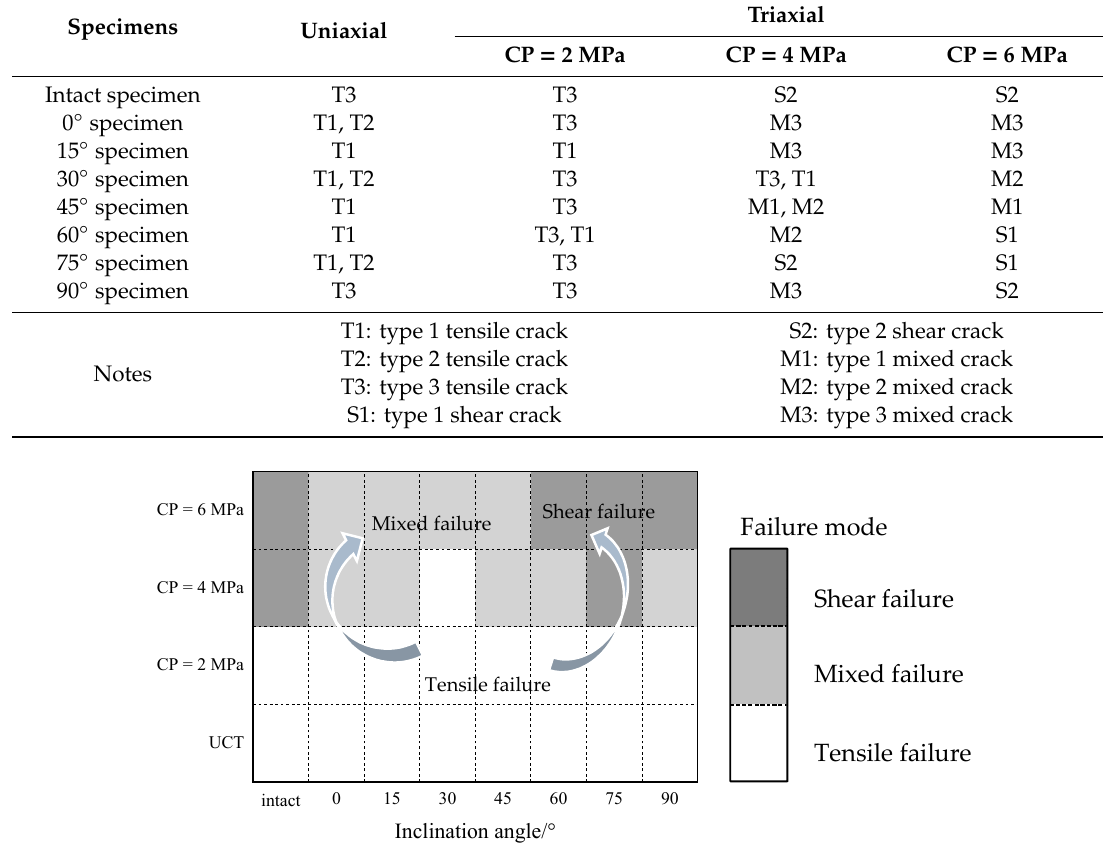
Table 2. Summary of all crack types observed in uniaxial and triaxial compression tests.